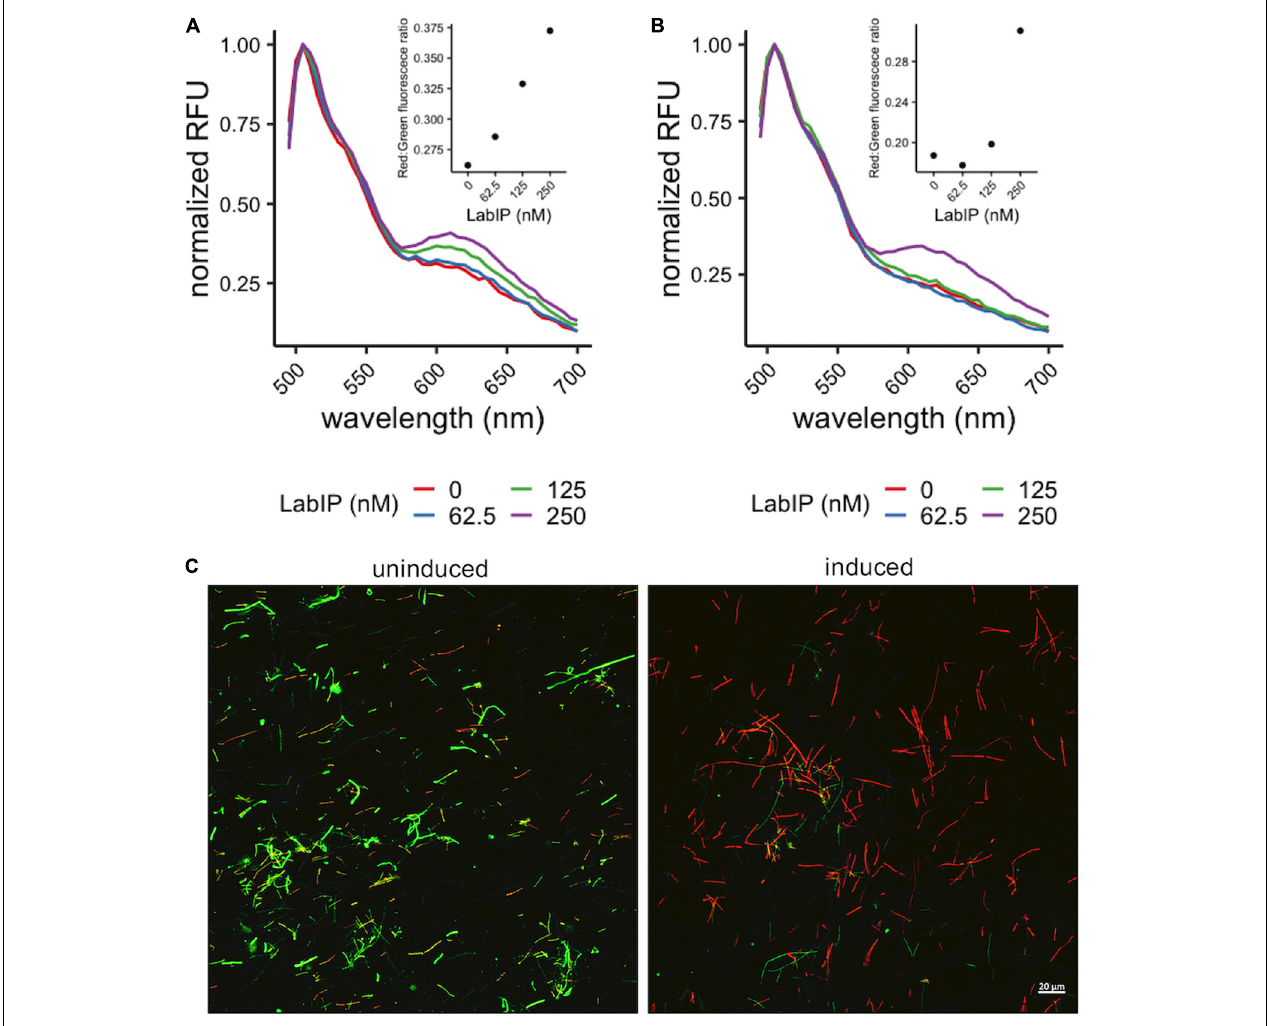
FIGURE 5 | Pore formation caused by MV-associated bacteriocins. Increase in red wavelength fluorescence from LIVE/DEAD stain indicates peptides in the LabIP-induced L. acidophilus ATCC 53544 supernatant (A) and those associated with MVs (B) create pores in the L. delbrueckii cell wall and/or membrane. (C) Representative fluorescence microscopy images of LIVE/DEAD-stained L. delbrueckii show an increase in red-fluorescing cells after incubation with MVs from LabIP-induced L. acidophilus, while L. delbrueckii treated with MVs from non-induced cultures show a minimal number of red-fluorescing